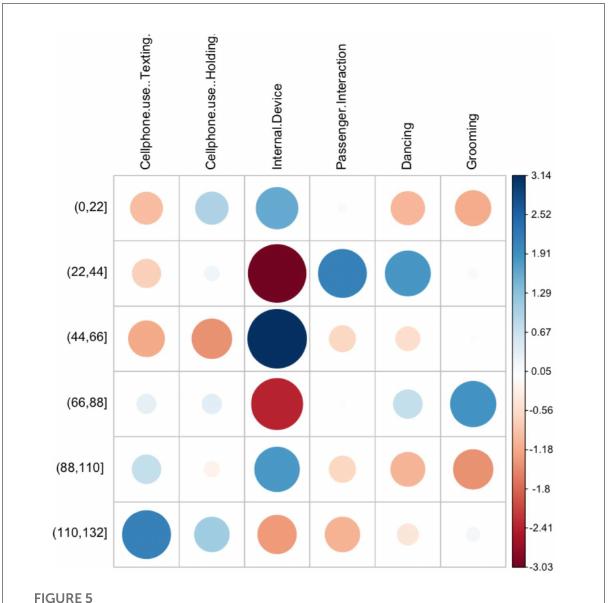
FIGURE 5 Pearson residuals for speed and secondary task type.